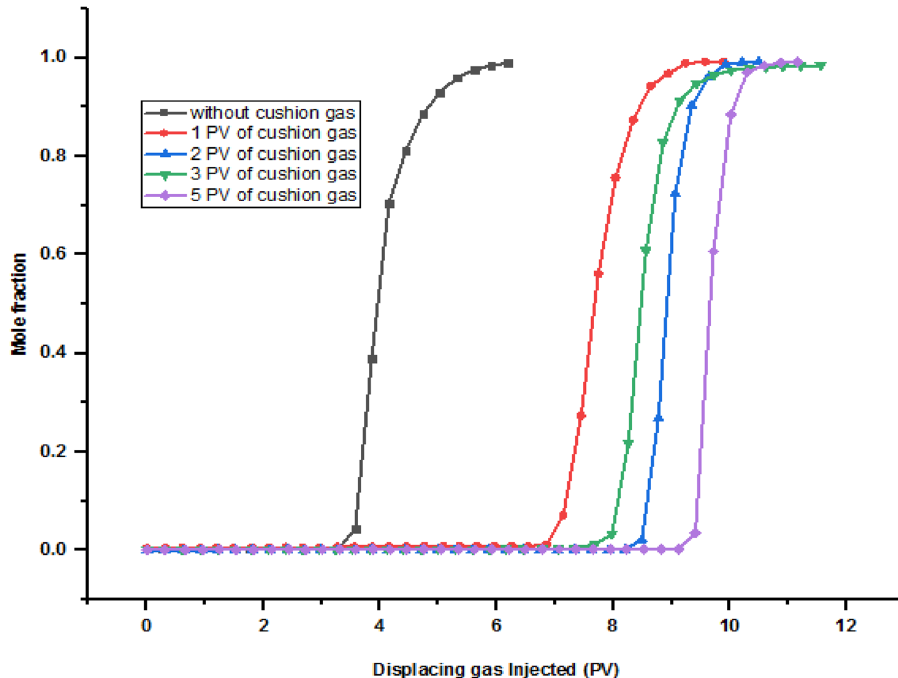
Fig. 9 CO 2 breakthrough time of all the experimental